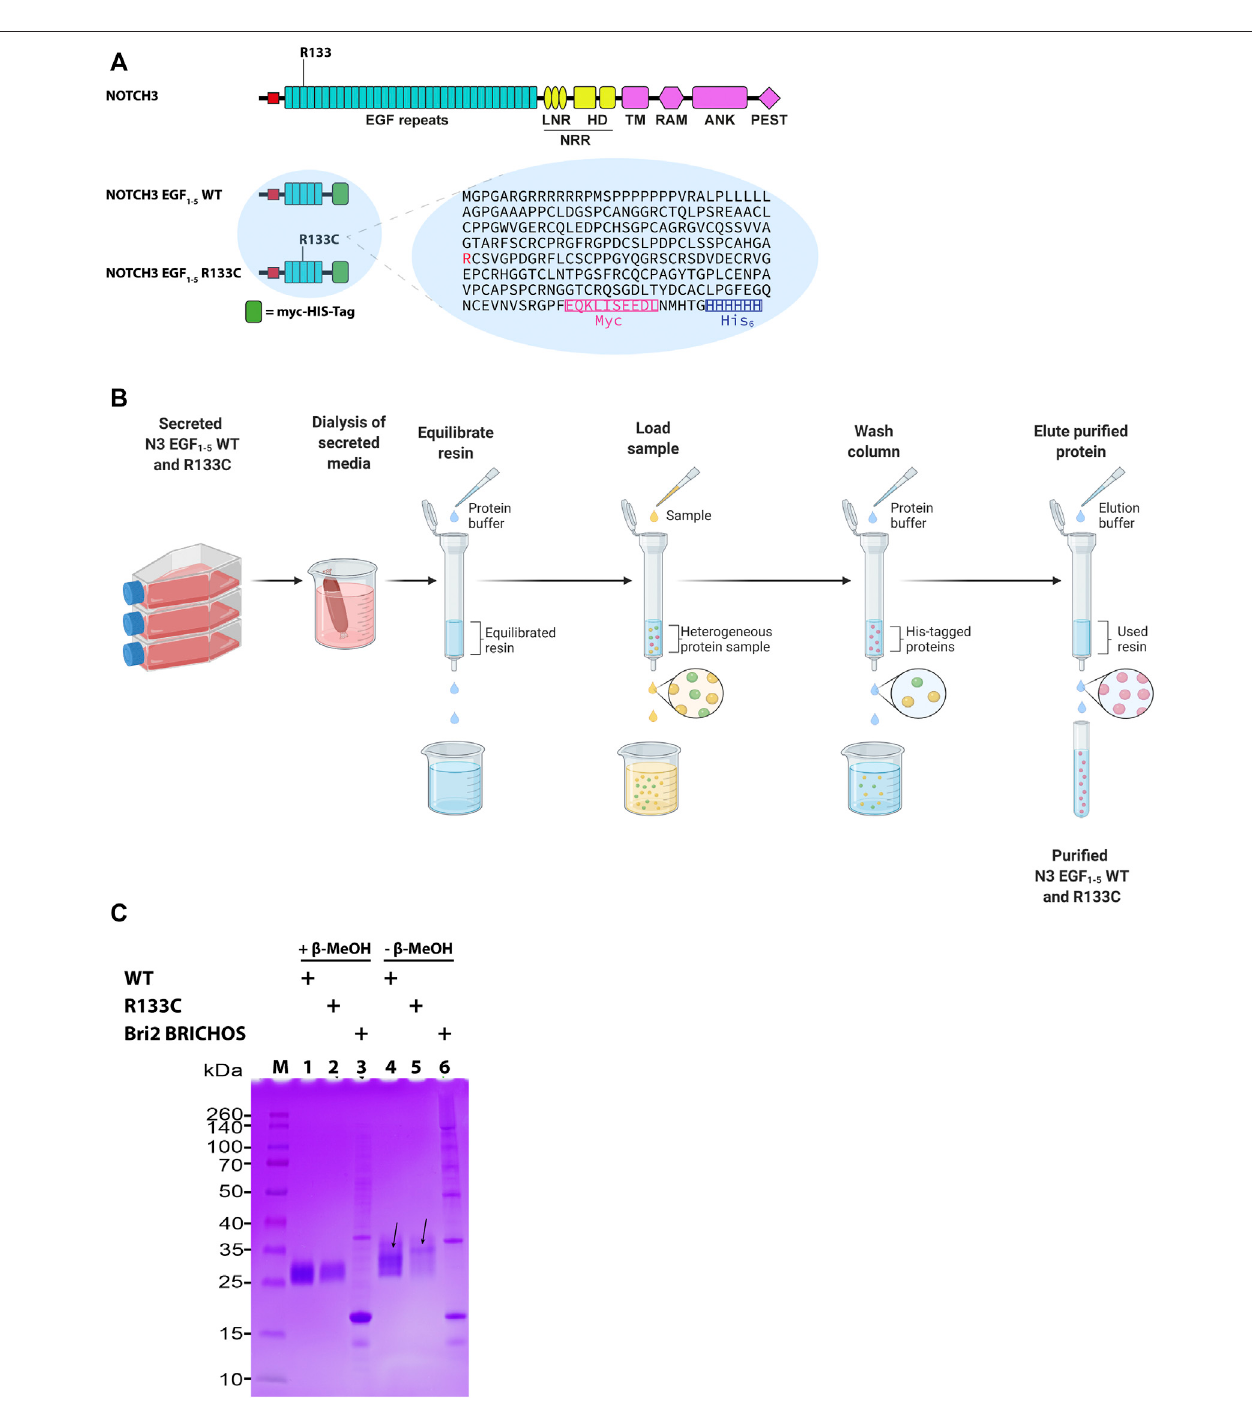
FIGURE 1 | The architecture of N3 EGF 1 – 5 . (A) Schematic representation of NOTCH3 and NOTCH3 EGF 1 – 5 WT and R133C. NOTCH3 represents the full-length protein, and NOTCH3 EGF 1 – 5 represents the NOTCH3 protein with exons 1 to 5 fused with a myc-His-tag at the C-terminus used for puri fi cation of proteins. Arg133, whichismutatedtoCysR133,isshowninredintheaminoacidsequence. (B) Schematicrepresentationofthepuri fi cationoftheN3EGF 1 – 5 WTandR133Cproteins. (C) SDS-PAGE of puri fi ed WT N3 EGF 1 – 5 and R133C mutant proteins under reducing and non-reducing conditions. In addition, the recombinant Bri2 BRICHOS was also analyzed in a similar way. The arrows depict the plausible different monomeric forms with different molecular intramolecular disul fi de bonds under non-reduced condition. The SDS-PAGE is a representative fi gure of three independent experiments performed in triplicate ( n = 3).